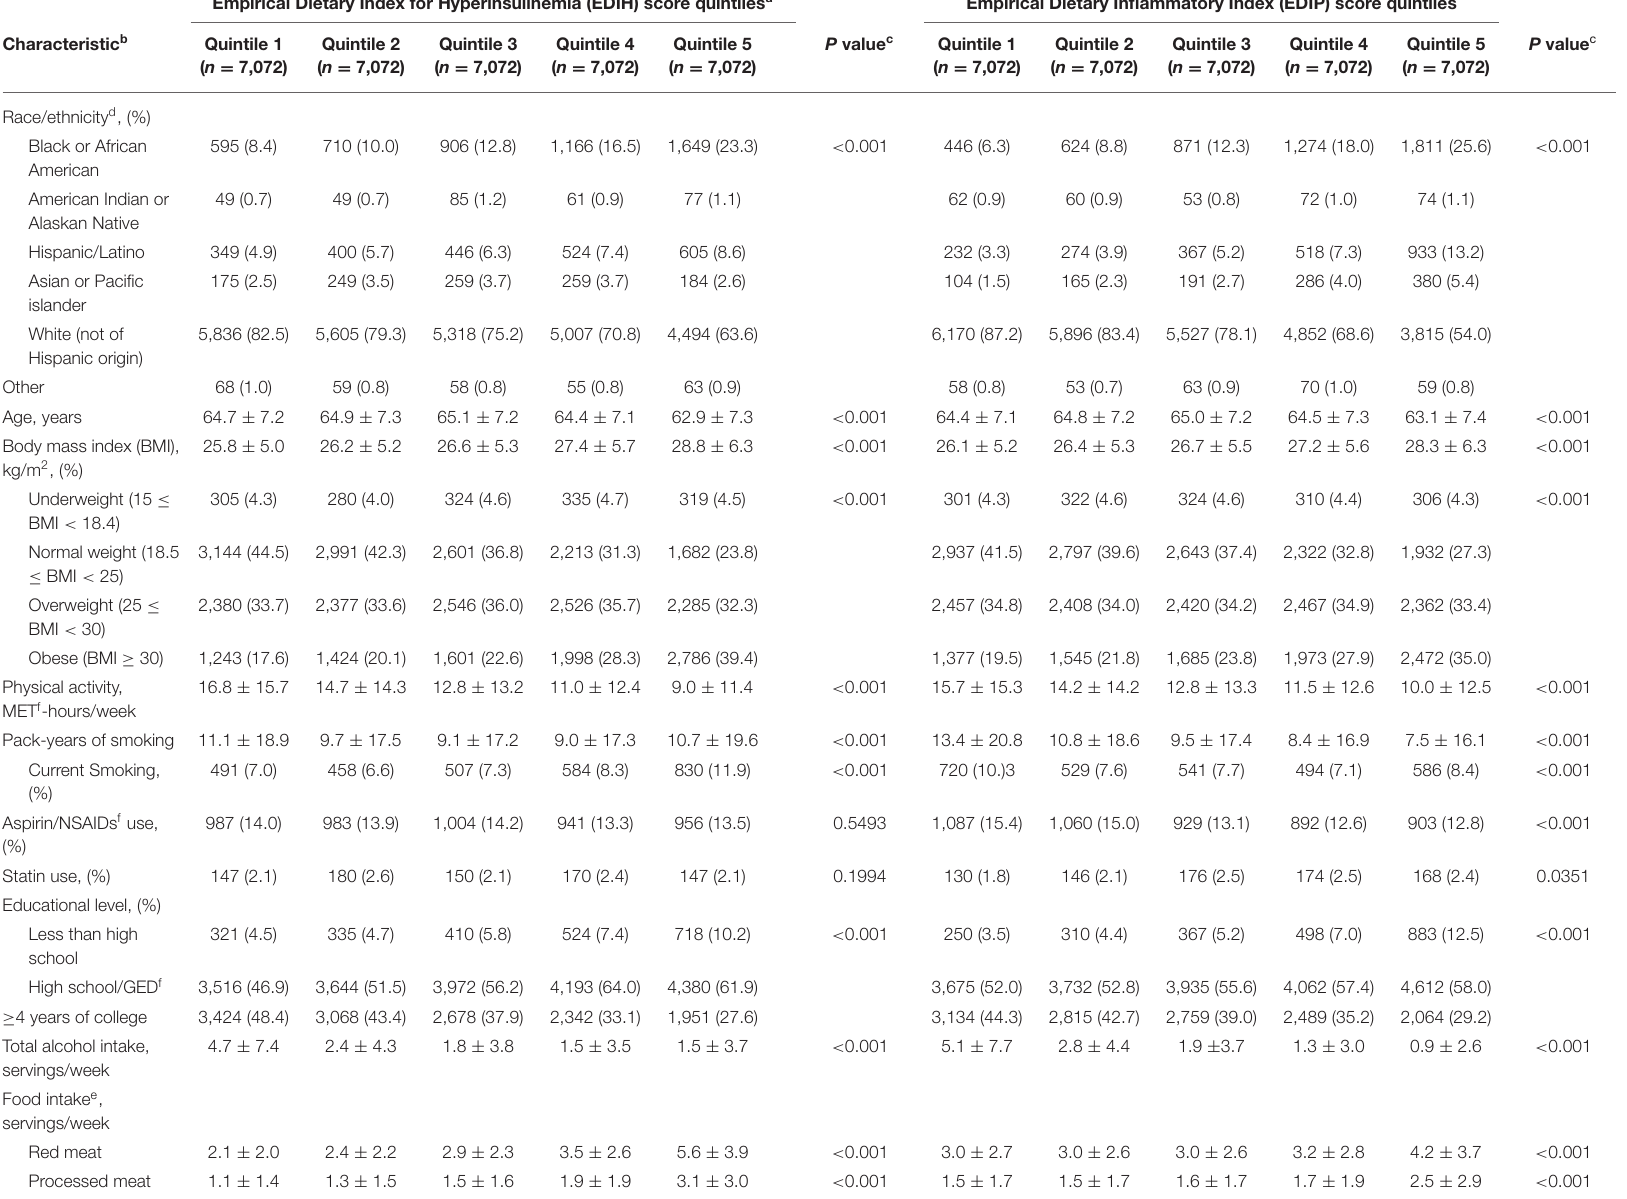
TABLE 1 | Baseline characteristics of the study sample in quintiles of dietary indices among 35,360 postmenopausal women in Women’s Health Initiative. Empirical Dietary Index for Hyperinsulinemia (EDIH) score quintiles a Empirical Dietary Inflammatory Index (EDIP) score